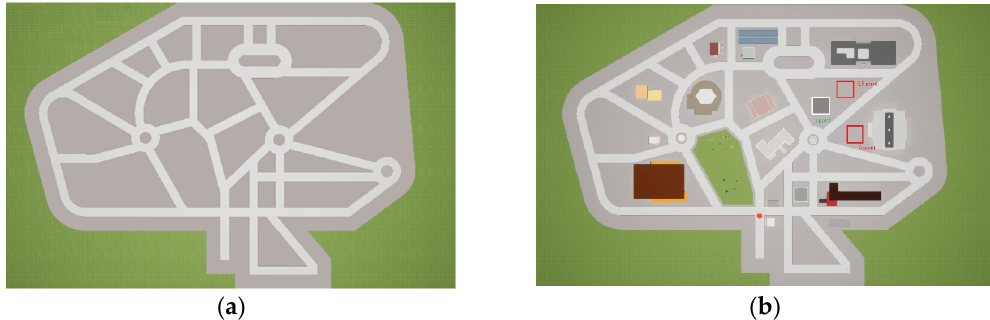
Figure 2. Sketched map used in map-completion task ( a ) and examples of scoring (0 point, 0.5 point, 1 point) for landmarks number 10 (lunch bar) in map-completion task ( b ).